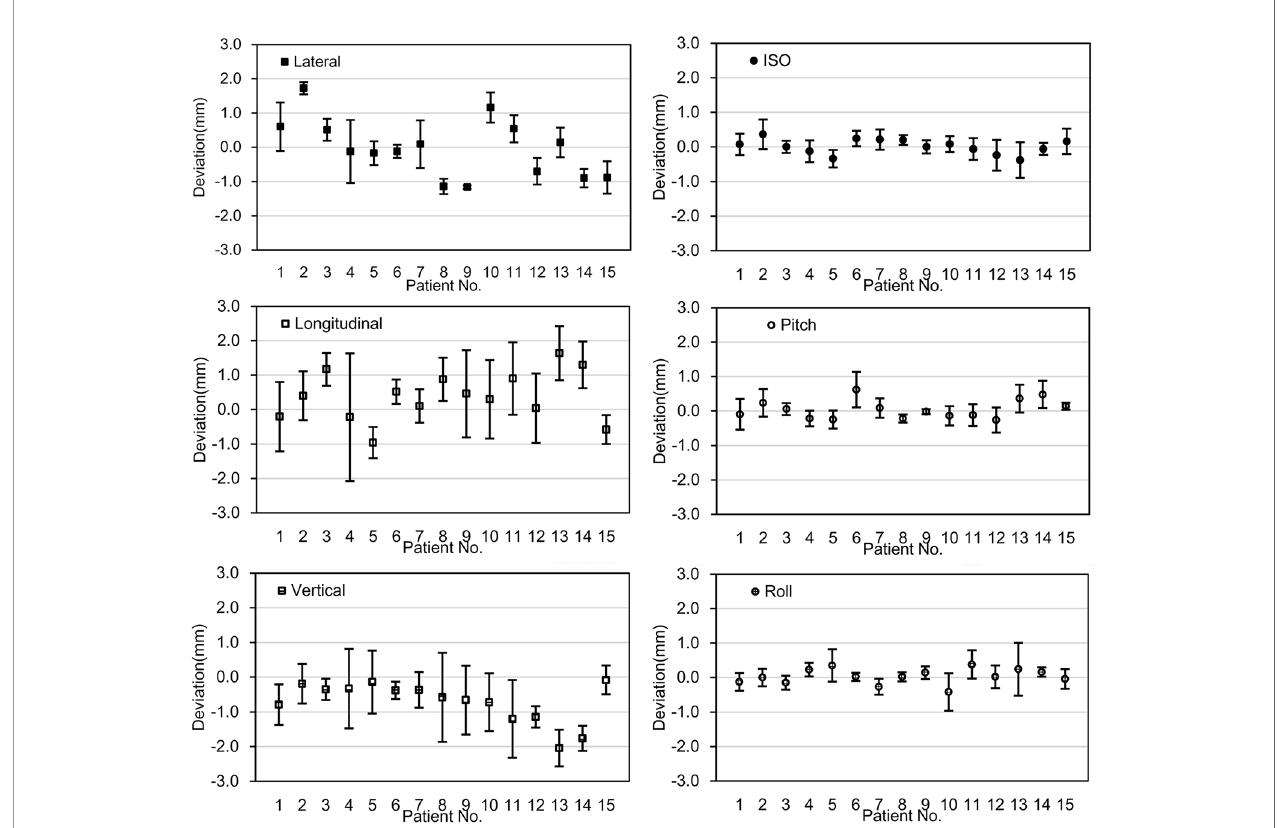
FIGURE 3 | The deviation between PE-B1 and PE-B2. The x-axis represents the fi fteen individual patients; the y-axis represents the mean value of the deviation of the speci fi c patient in 6 degrees of freedom. Error bars represent for the standard deviation.